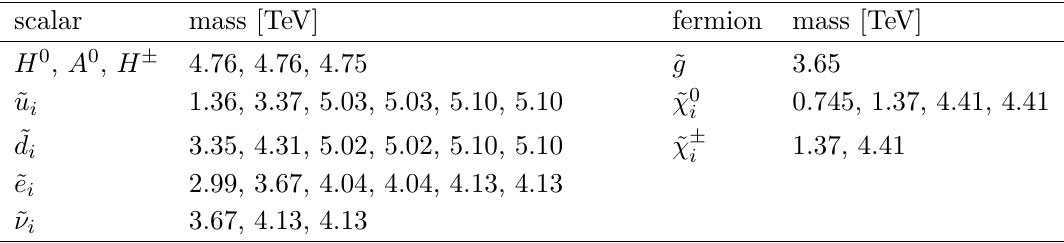
Table 3 . The masses of MSSM particles for the cMSSM point from eq. (4.1).